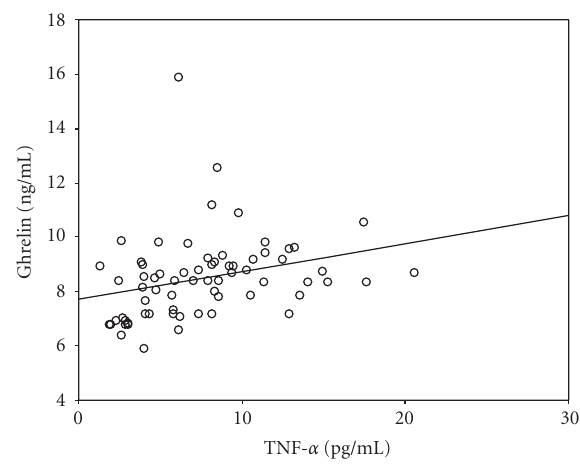
Figure 2: The relation of ghrelin and TNF- α . There was a positive correlation between ghrelin and TNF- α ( r : 0 . 290, P < .